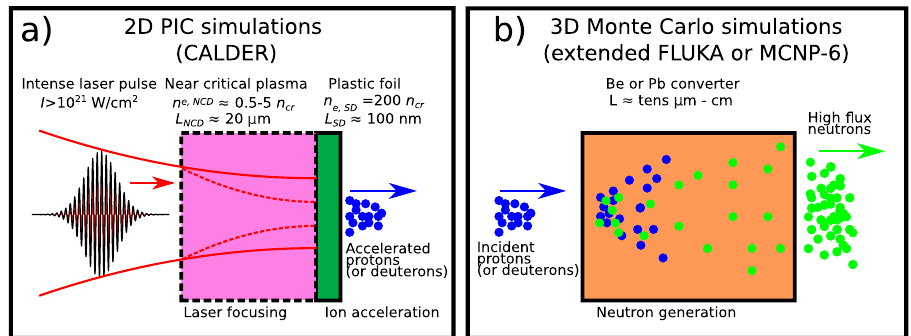
Figure 1. Numerical methodology. ( a ) In the first stage, 2D PIC simulations are performed, using the calder code, to optimise proton (or deuteron) acceleration with either single- or double-layer targets (see text). ( b ) The accelerated protons (or deuterons) are then sent to the 3D Monte Carlo fluka or mcnp-6 code to compute the neutron generation in a secondary beryllium or lead